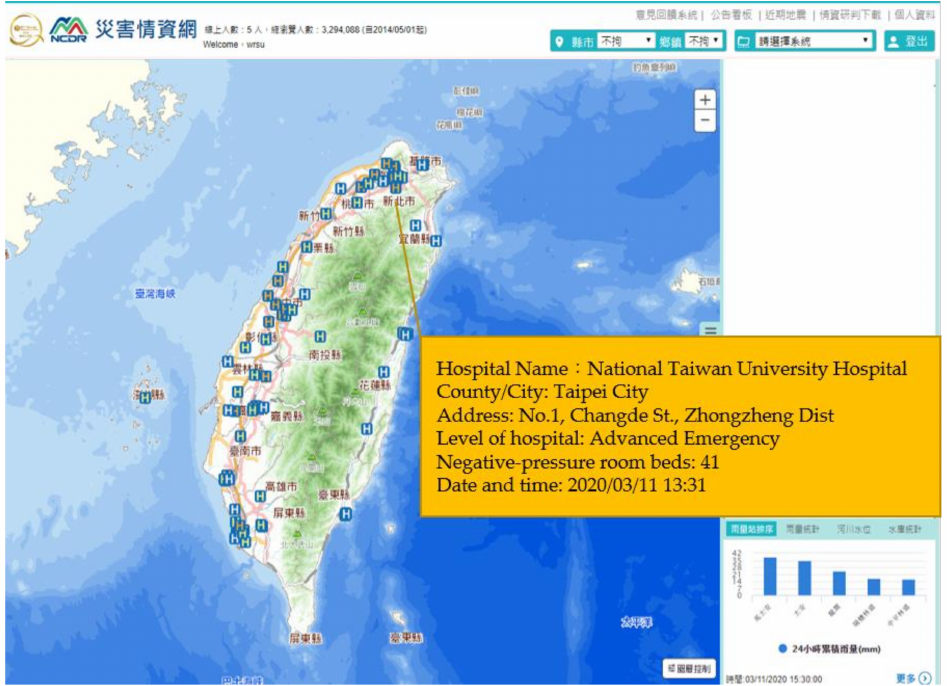
Figure 4. Pandemic intelligence system—dynamic distribution of hospital